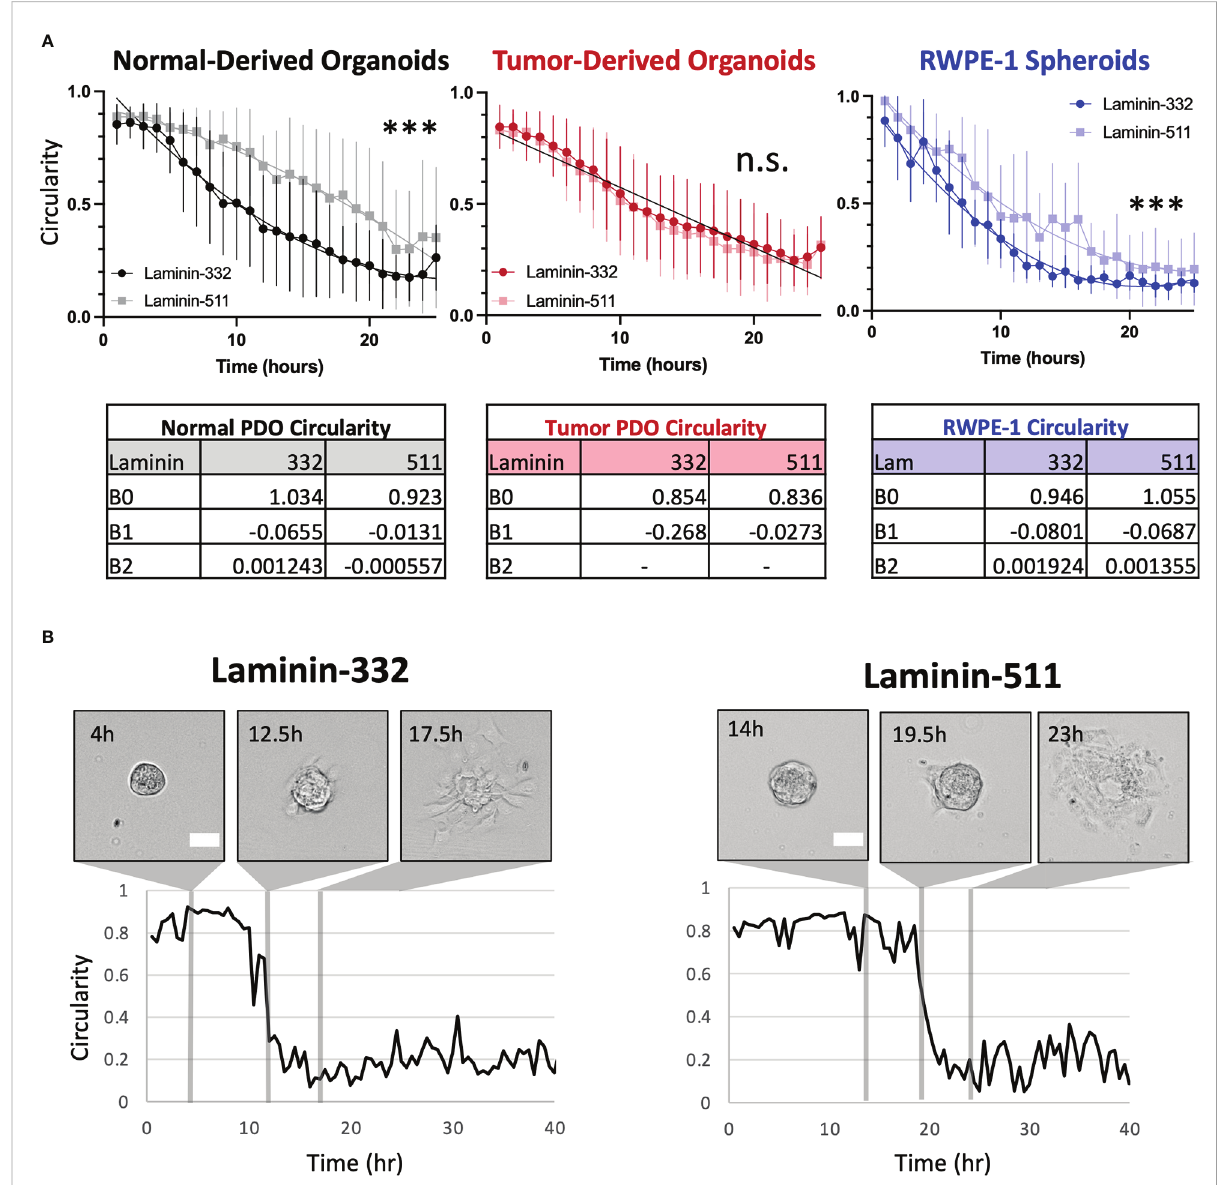
FIGURE 1 (A) Organoids from normal tissue spread more quickly on Laminin-332 than on Laminin-511 substrate. Line plots of average circularity +/- SD (error bars) per substrate for normal- (grayscale) and tumor-derived (red) organoids from 3 patients and RWPE-1 (blue) spheroids. Nonlinear fi tted curves are plotted on the normal graph (dark line, Lam-332; light line, Lam-511) ***p<0.0001, n.s = not signi fi cant. For tumor-derived organoids, substrate-speci fi c circularity curves are not signi fi cantly different (p=0.2406), and therefore a single, global curve is plotted (black line). Time to spreading was interpolated from the resultant curves using C = 0.60. Normal Lam-332, n = 24; Normal Lam-511, n = 7; Tumor Lam-332, n = 29; Tumor Lam-511, n = 23; RWPE-1 Lam-332 n= 6, RWPE-1 Lam511 n = 7. No outliers were detected in PDO samples, one detected and removed from RWPE-1 spheroid measurements (ROUT Q=1%). (B) Representative images with corresponding circularity measurements plotted over time for organoids derived from the normal prostate regions of one patient on either Laminin-332 or Laminin-511. Scale bar = 100 m